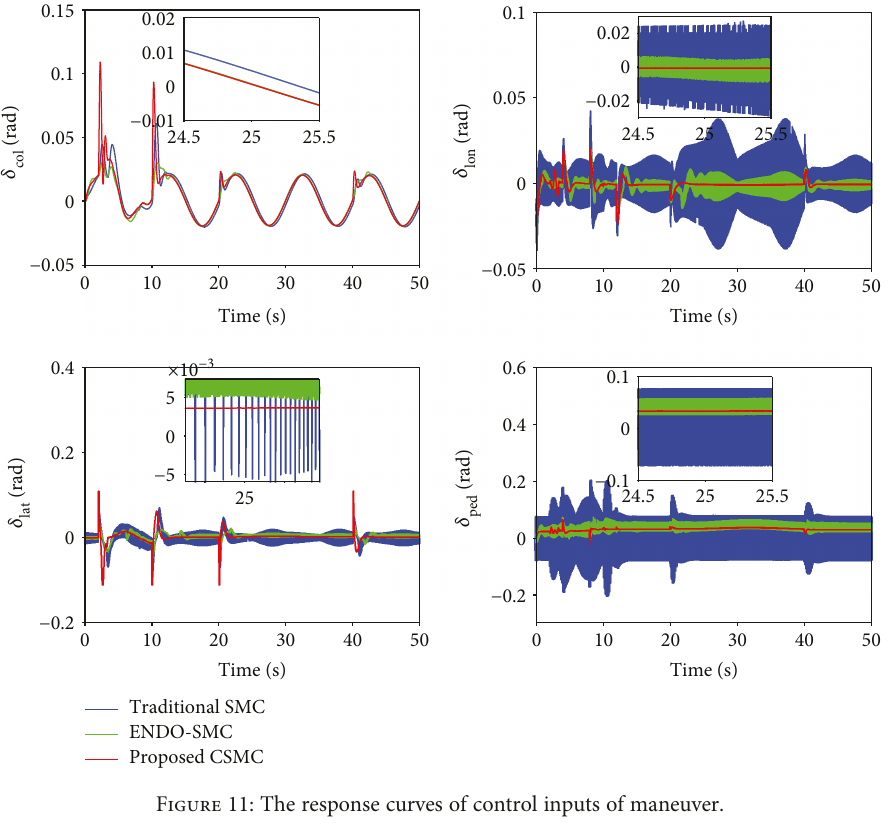
Figure 11: The response curves of control inputs of